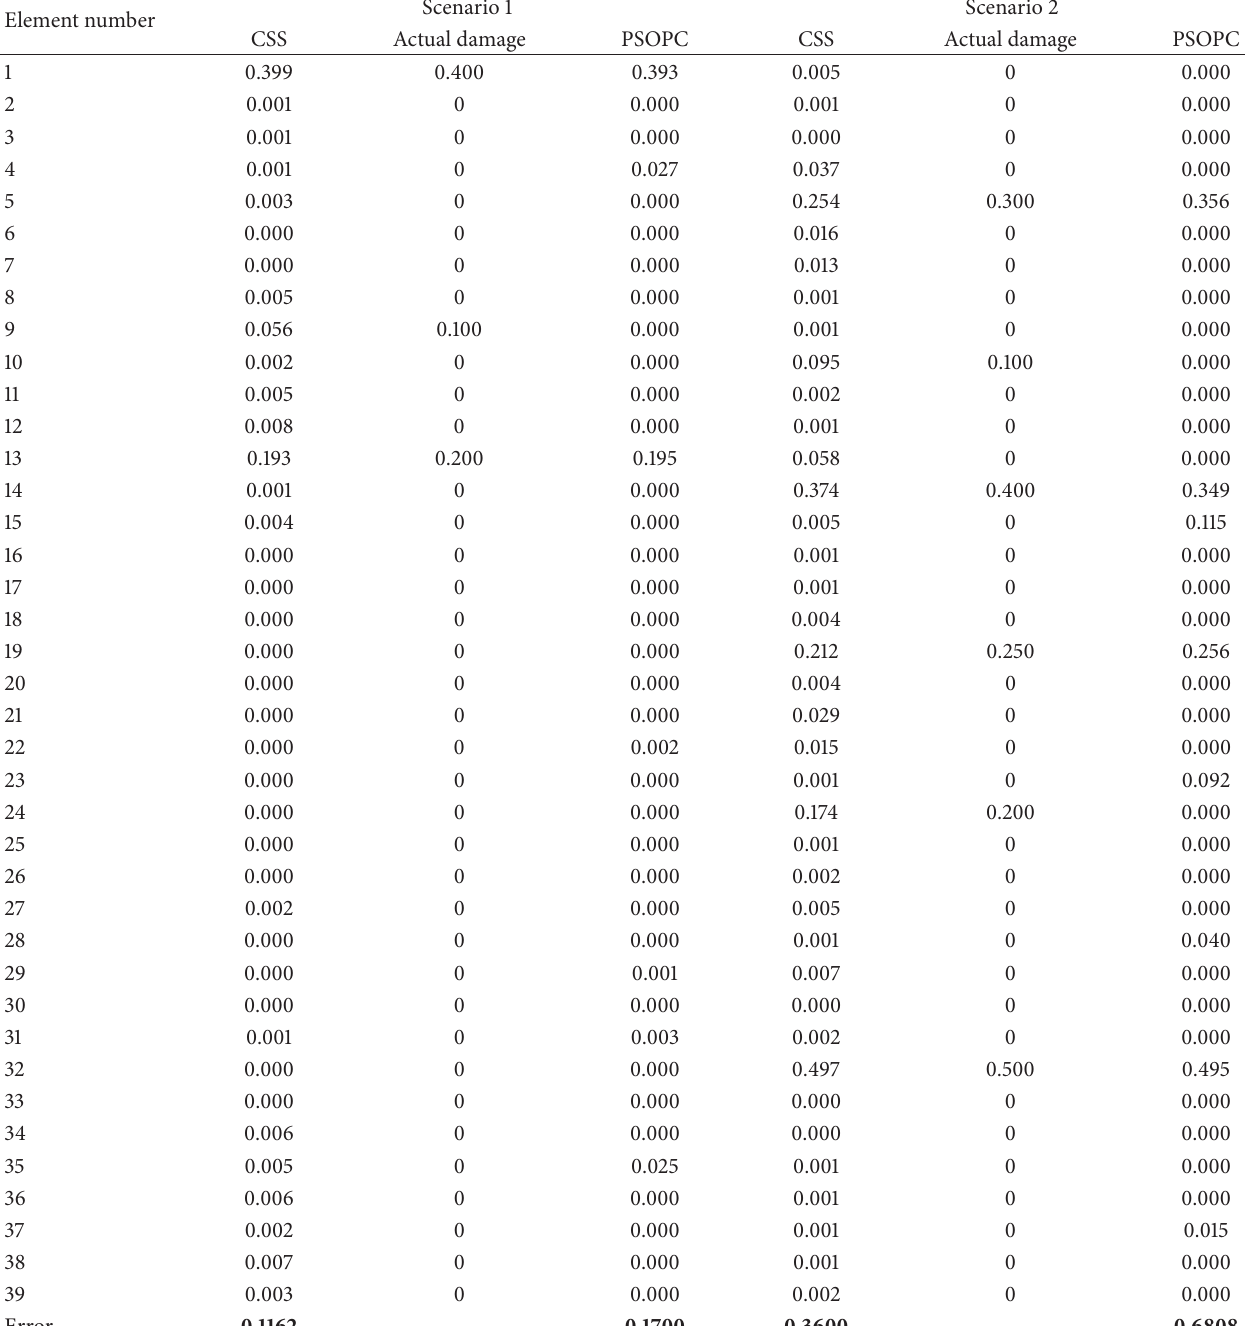
Table 9: Results of damage detection of the 39-element frame using CSS and PSOPC